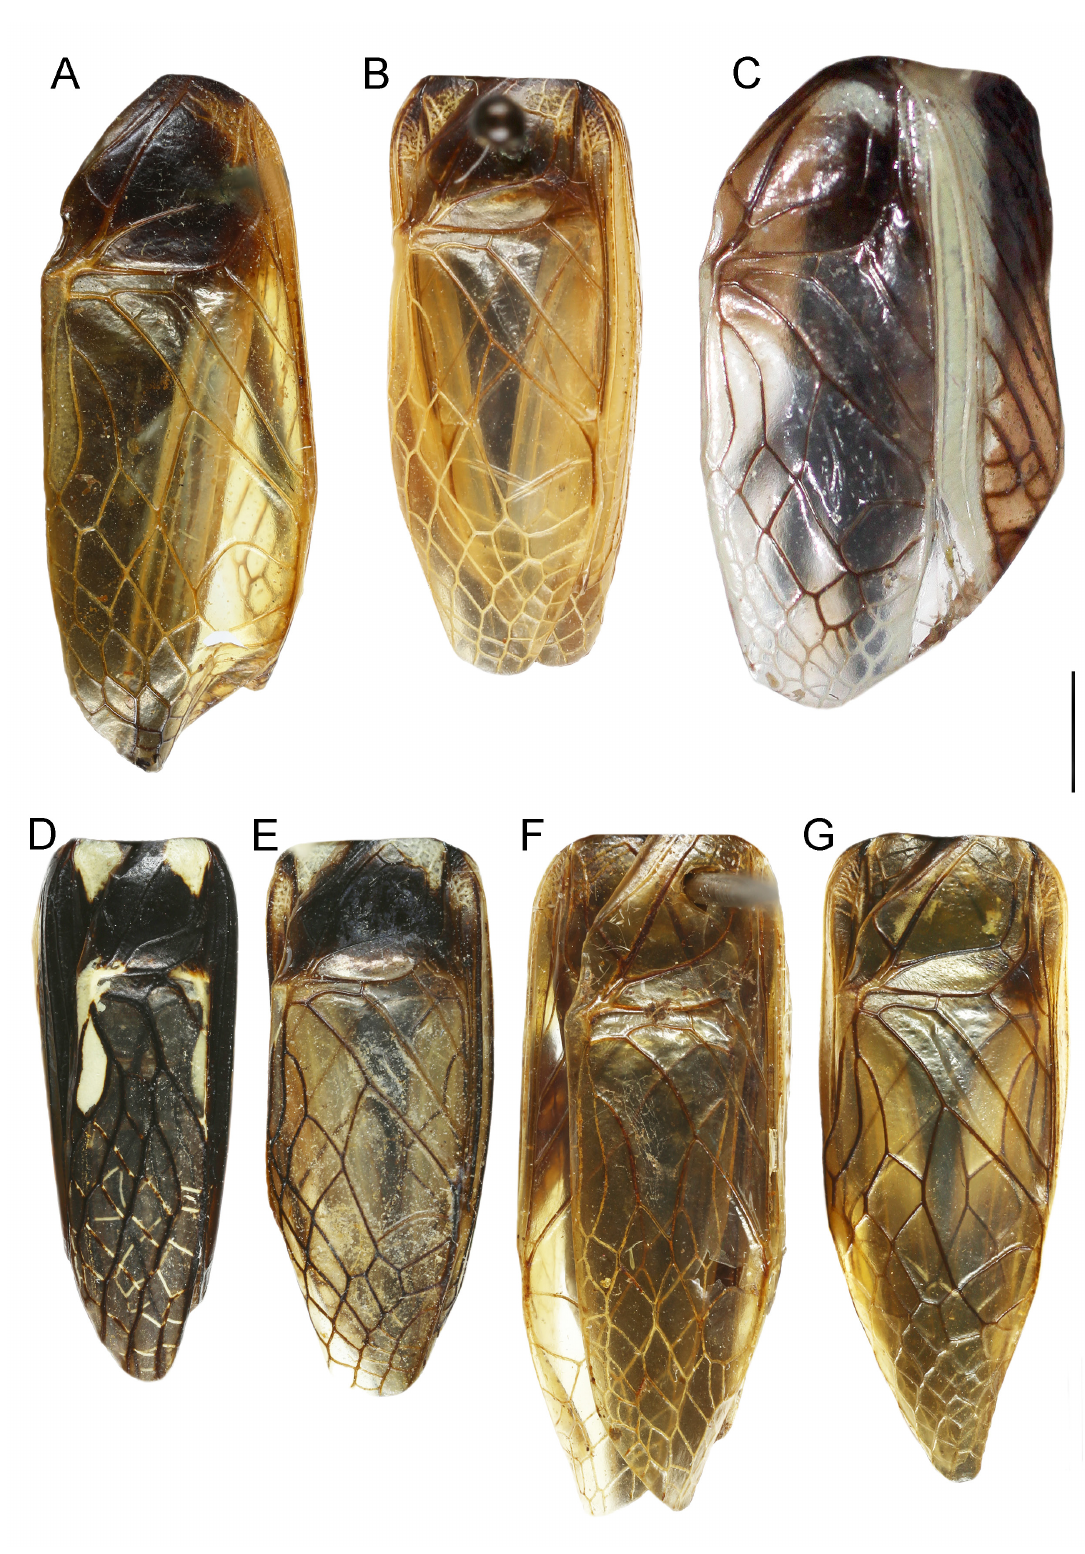
Fig. 13. Male tegmina in dorsal view. A . Nisitrus brunnerianus Saussure, 1878. B . N. crucius Robillard